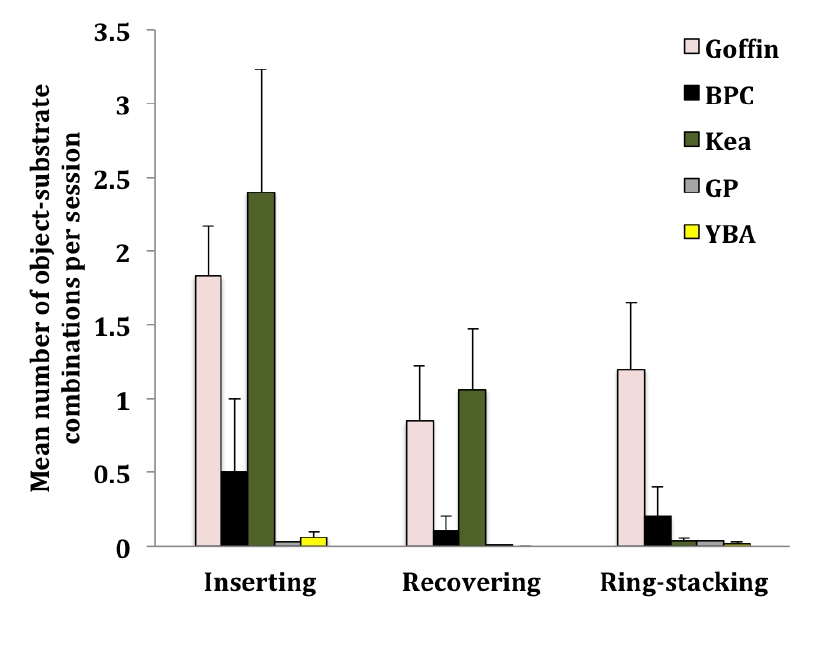
Figure 4. Mean number (± SE) of inserting, recovering and ring-stacking actions per session. The colors of the bar charts indicate different species (Note that objects can be recovered after both, ring-stacking and inserting instances): rose = Goffin ( N = 14), black = BPC ( N = 2), olive = kea ( N = 14), grey = GP ( N = 10), yellow = YBA ( N =